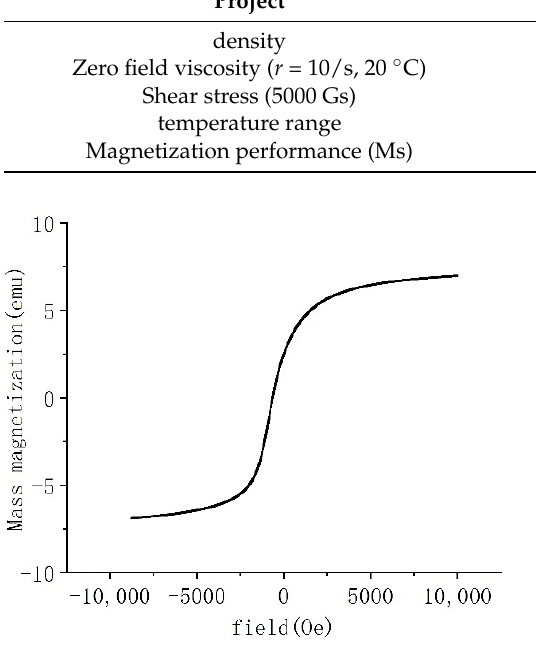
Figure 3. B–H curve of 45# steel.